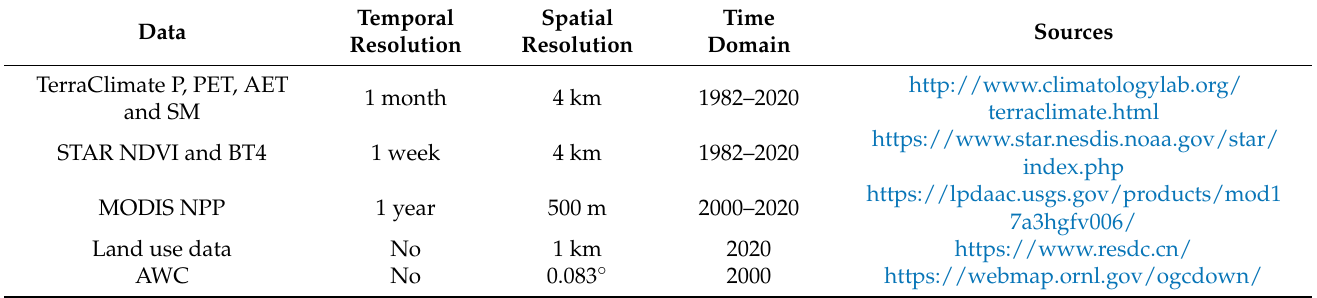
Table 1. The information of the